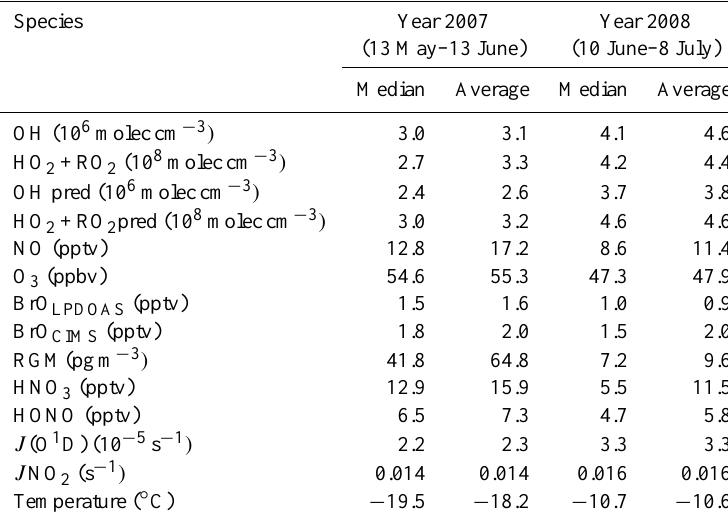
Table 3. Photochemical species concentrations and parameters in the mid-day (10:00–15:00WGST) at Summit, Greenland in 2007–2008. (Note: HO x predictions are from the base model.)